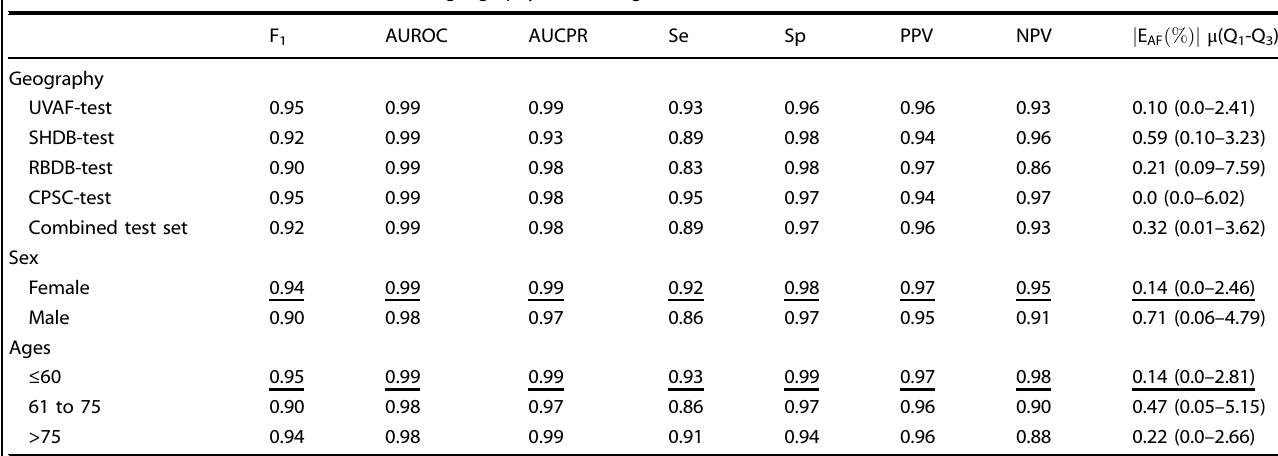
Table 2. Performance measures of ArNet2 across geography, sex and